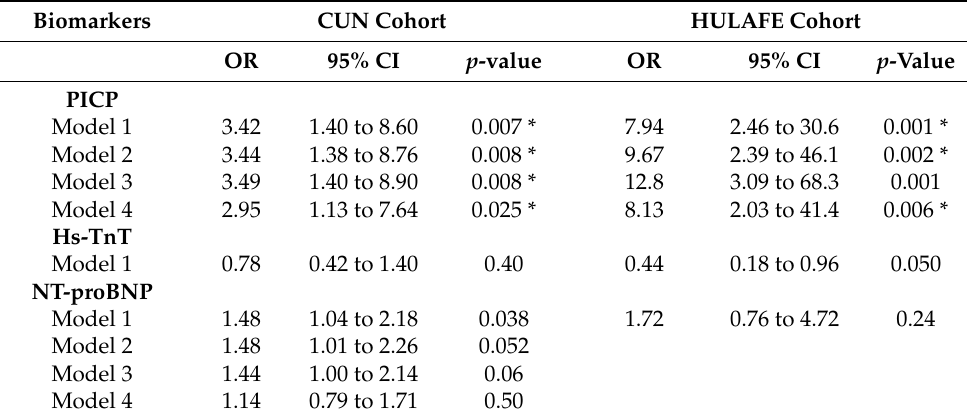
Figure 5. Biomarker changes from baseline to 3m-post-ACC and probability of cardiotoxicity at 12m-post-ACC in BC patients. Predicted probability of cardiotoxicity (solid black line) and 95% confidence intervals (color shade) at 12 months after completion of ACC as a function of PICP ( A , B ), hs-TnT ( C , D ) and NT-proBNP ( E , F ) variations (log2) from baseline to 3m-post-ACC, in the CUN and HULAFE cohorts, after partly conditional logistic regression analyses with adjustment for the respective biomarker baseline values. BC, breast cancer; ACC, anthracycline-based cancer chemotherapy; NT-proBNP, amino-terminal pro-brain natriuretic peptide; hs-TnT, high-sensitivity troponin T; PICP, procollagen type-I C-terminal propeptide. Table 5. Partly conditional logistic models to analyze longitudinal associations between repeated assessments of changes in biomarkers from baseline to 3m-post-ACC and risk of cardiotoxicity at